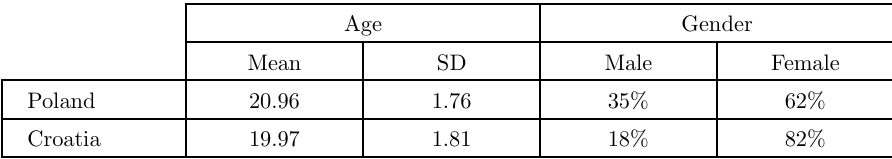
Participants by age, gender, and nationality Age Gender Mean SD Male Female Poland 20.96 1.76 35% 62% Croatia 19.97 1.81 18%